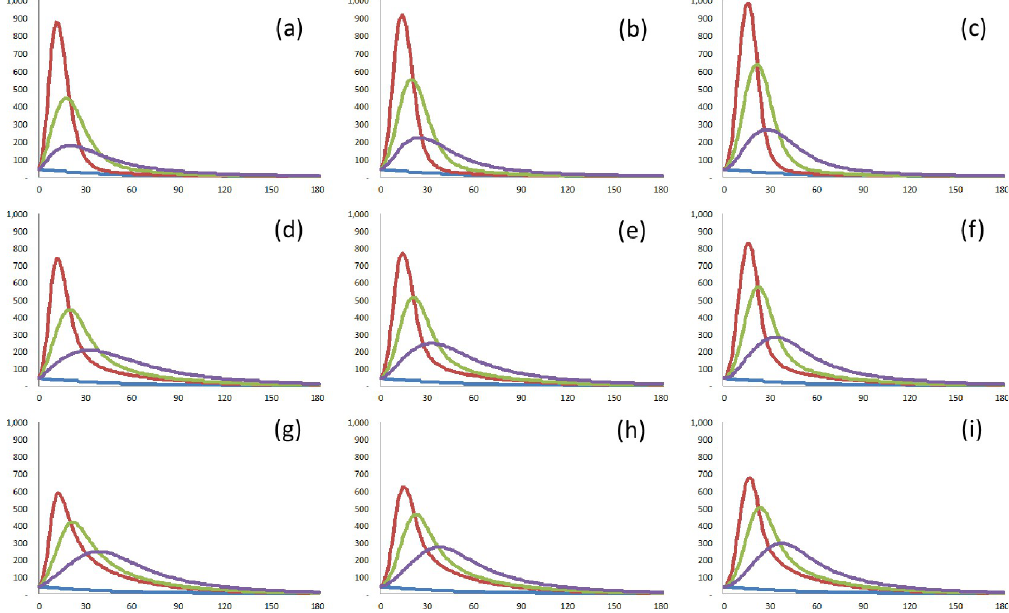
Fig 6. Demonstration of the effects of social distancing. The confirmed cases without a new wave (default; blue solid line), the confirmed cases with q = 0.4 (red solid line), the confirmed cases with q = 0.2 (green solid line), and the confirmed cases with q = 0.1 (violet solid line). (a) A = 1.0, I A = 0.75, I med = 5.6. (f) A = 0.75, I med = 7.5. (g) A = 0.5, I med = 3.7. (h) A = 0.5, I med = 5.6. (i) A = 0.5, I med =